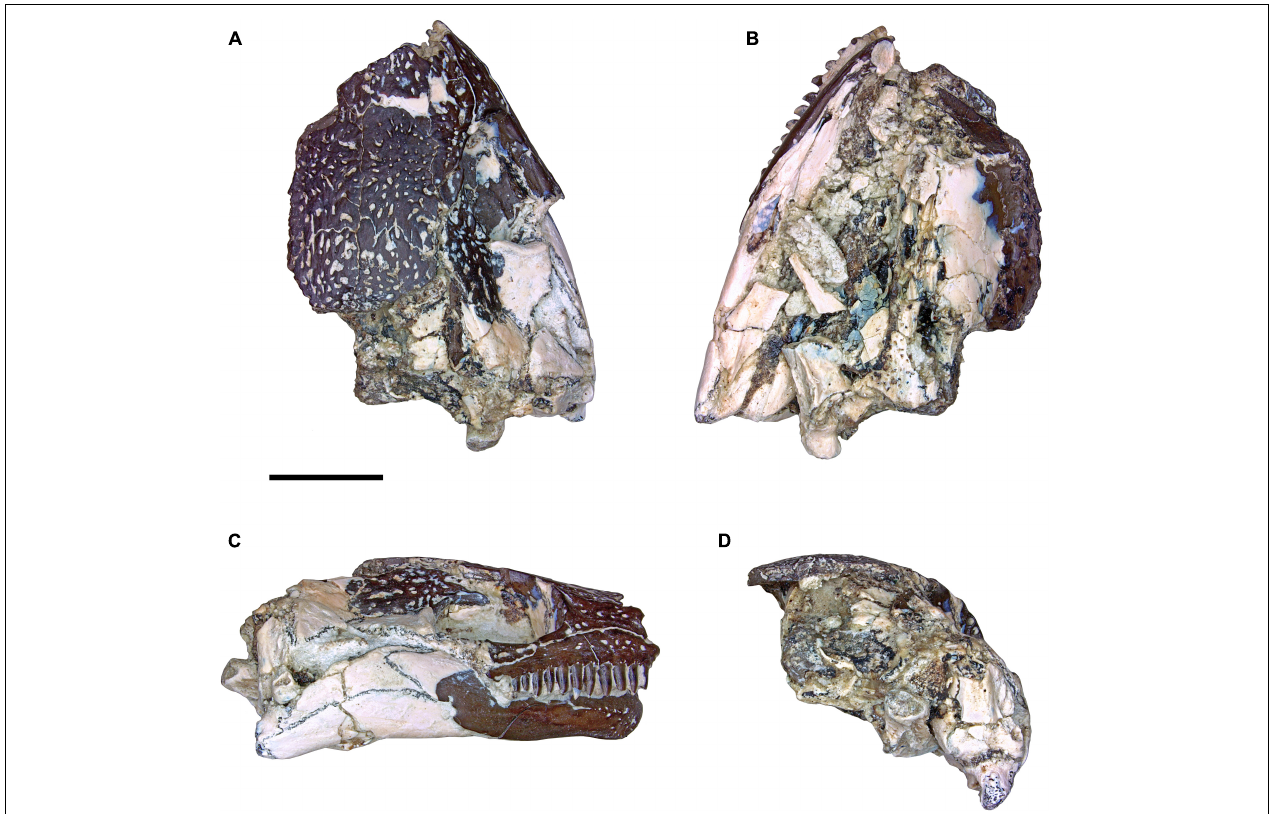
FIGURE 6 | Photographs of the partial skull of Nannaroter mckinziei , ROMVP 86541. (A) Dorsal view, (B) ventral view, (C) right lateral view, and (D) occipital view. Scale bar equals 5